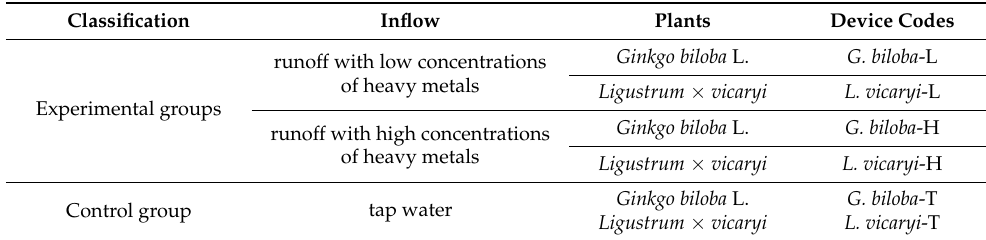
Table 1. Experimental treatments information and